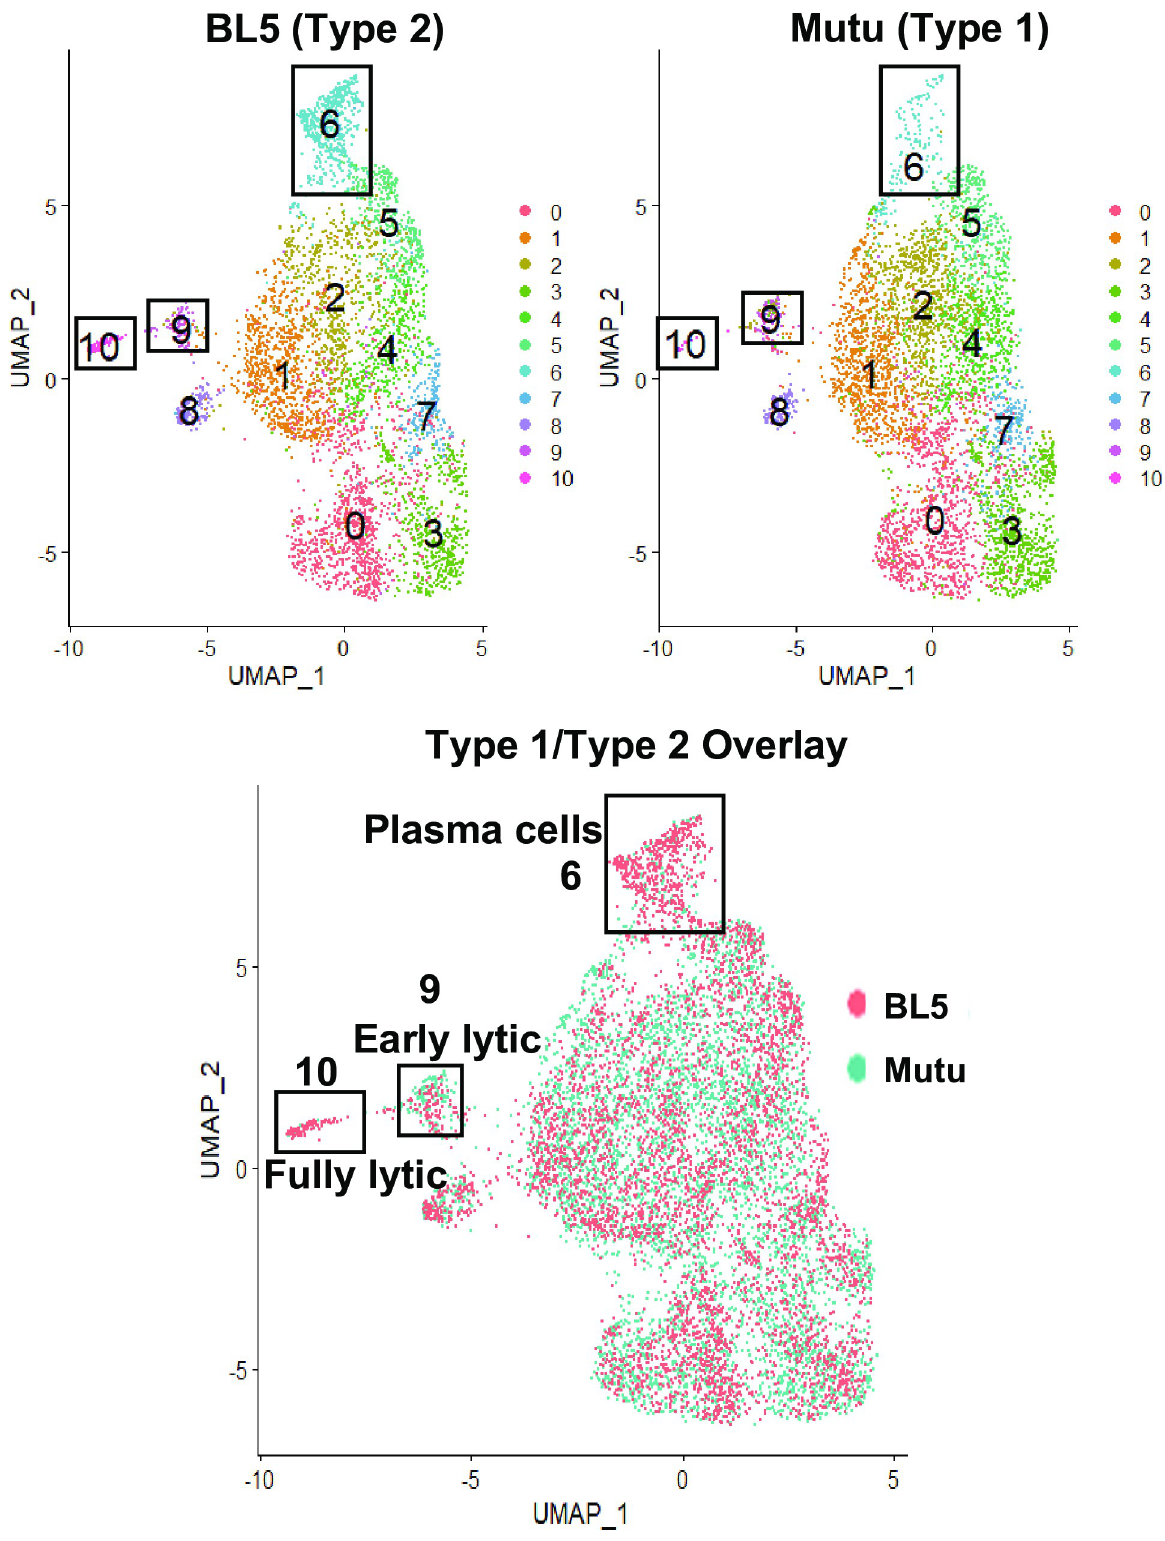
Fig 11. Both T1 and T2 LCLs can be separated into 11 separate clusters in scRNA-seq analysis. Single cell projection onto 2 UMAP dimensions using high dimensional reduction (see Materials and Methods) separated by BL5 and Mutu samples (top) as well as together (bottom) with overlaid different colors are